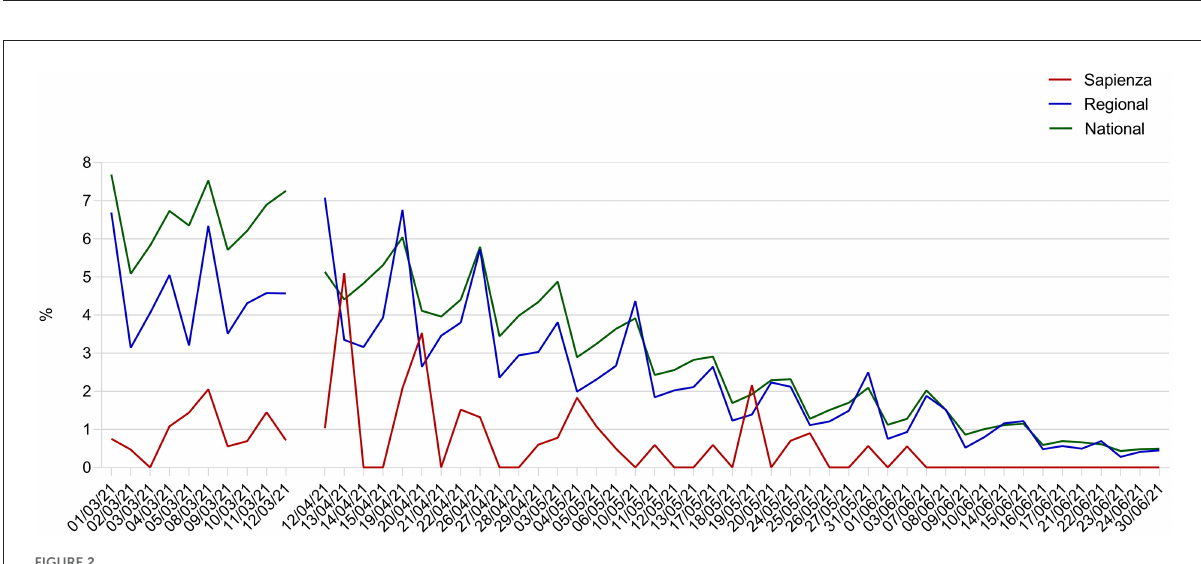
with a COVID-19 case or someone with signs and/or symptoms suggestive of COVID-19 compared to 12.5% of